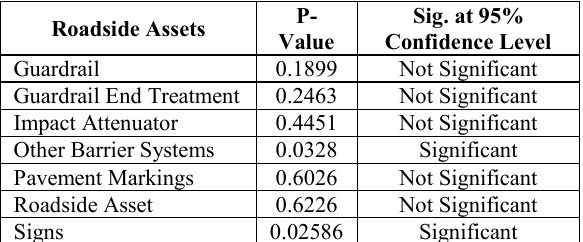
Table 4 . Results of Wilcoxon Test for Data Level of Detail usage across the different assets of the Roadside Asset